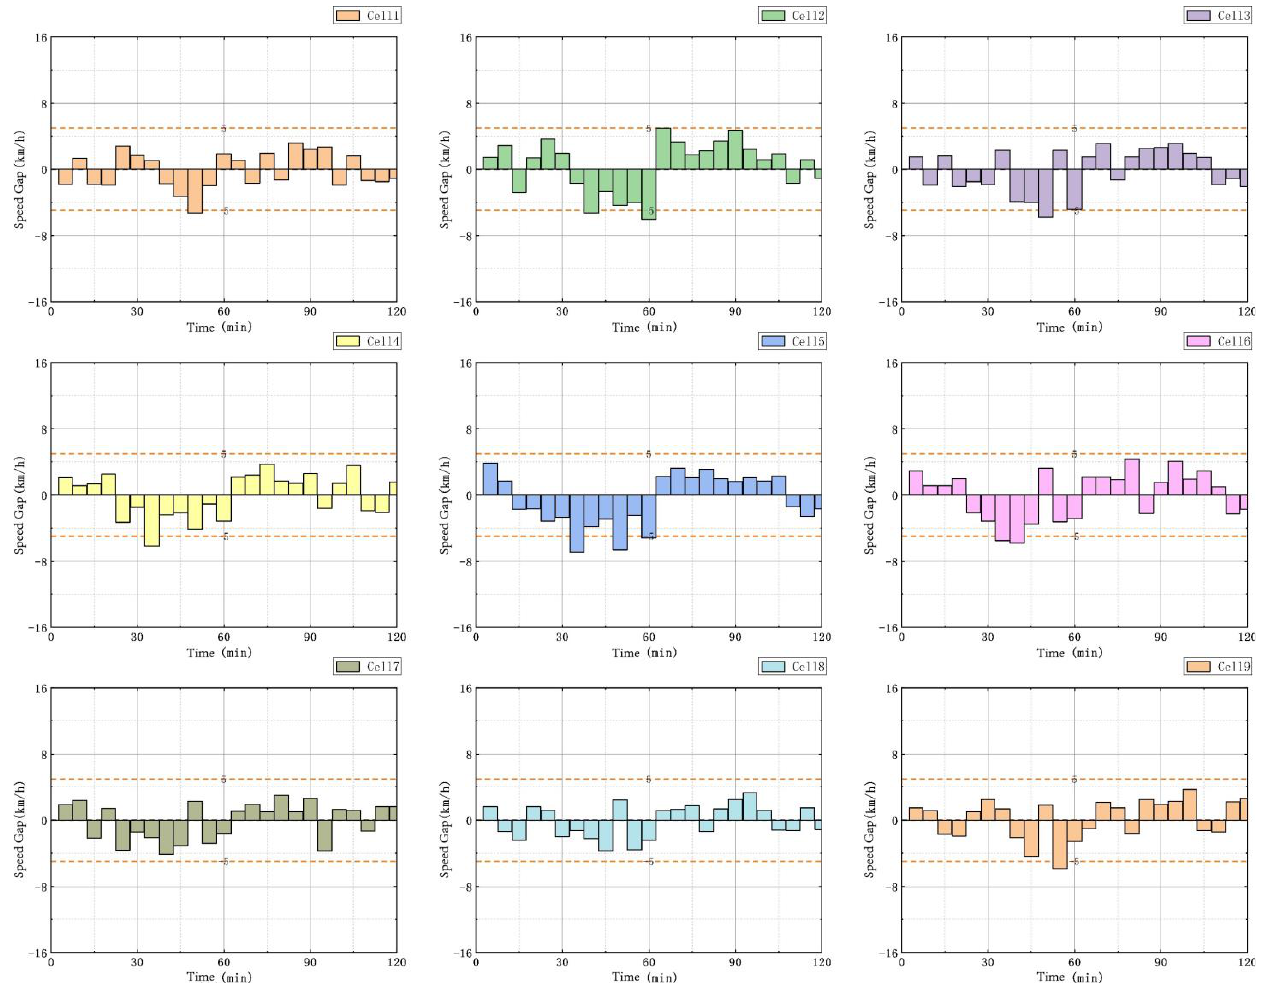
Figure 20. Time speed difference under coordinated control.